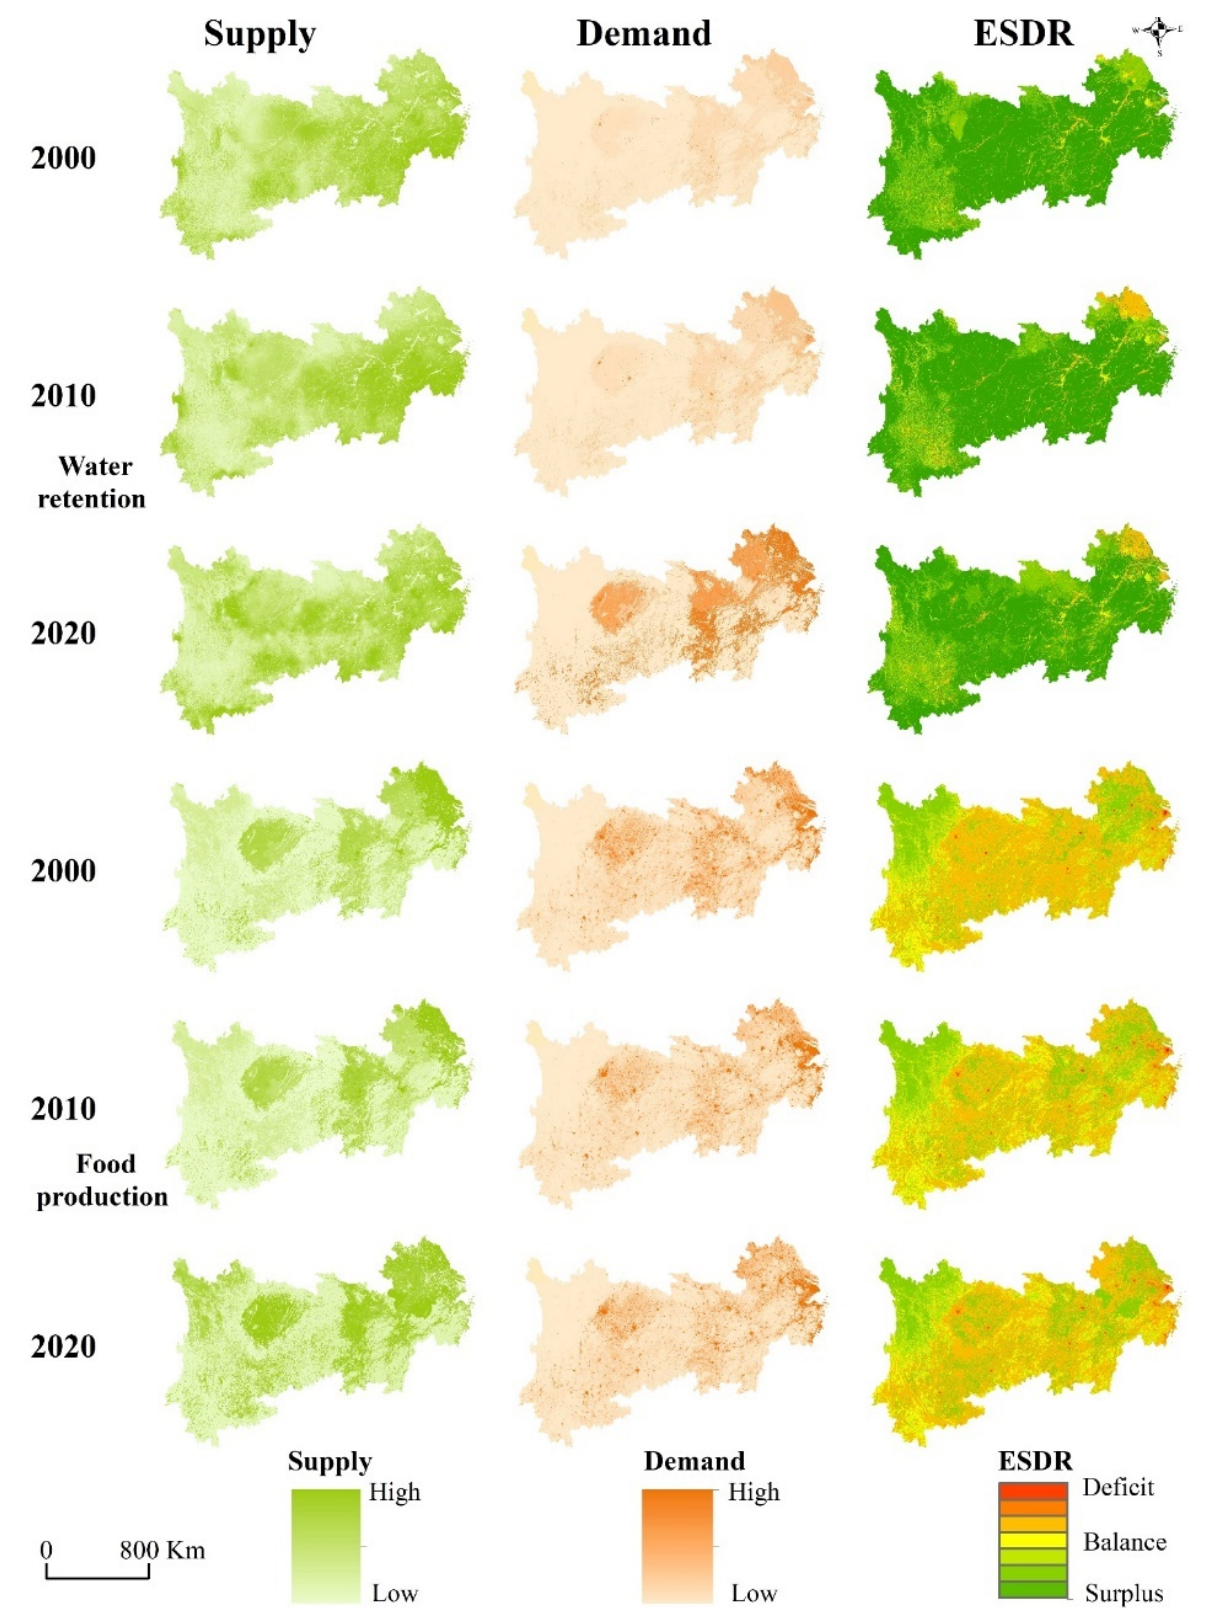
Figure 4. Spatial distribution of supply (left column), demand (middle column), and ESDR (right column) for water retention and food production in the YREB from 2000 to 2020.